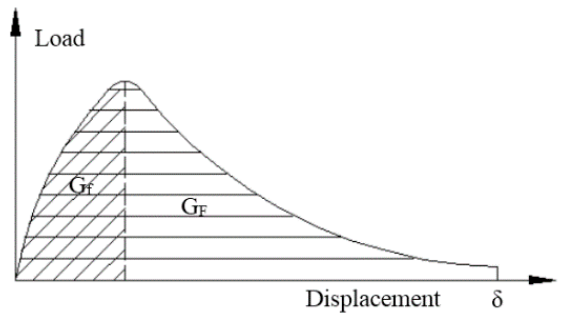
G in the load–displacement curve [30]. Figure 4. Di ff erence between G f and G F in the load–displacement curve G and F f